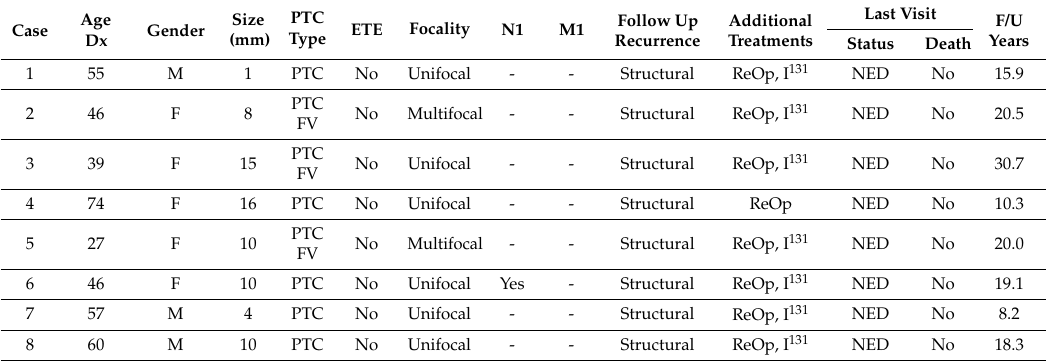
Table 4. Baseline characteristics and disease outcome of papillary thyroid cancer (PTC) patients with excellent response at 1-year and disease recurrence during